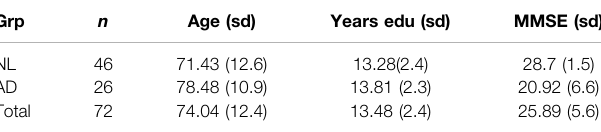
TABLE 1 | Demographic Summary of